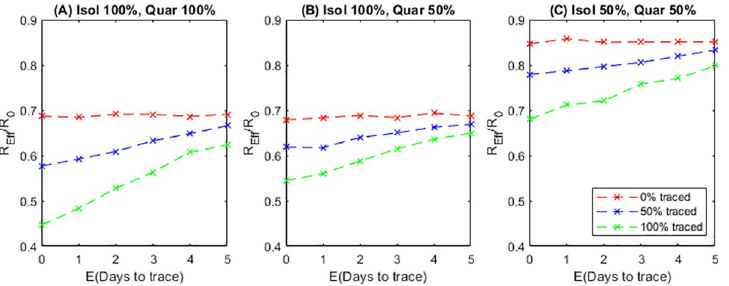
Fig 2. The impact of contact tracing on the effective reproduction number R eff is strongly affected by the proportion of contacts traced, the tracing speed and the effectiveness of quarantine and isolation. Graphs show the effective reproduction number relative to the no-control scenario ( R eff / R 0 ) against the mean tracing time, E (Days to trace), for a range of tracing probabilities and quarantine/isolation effectiveness. R tracing or case